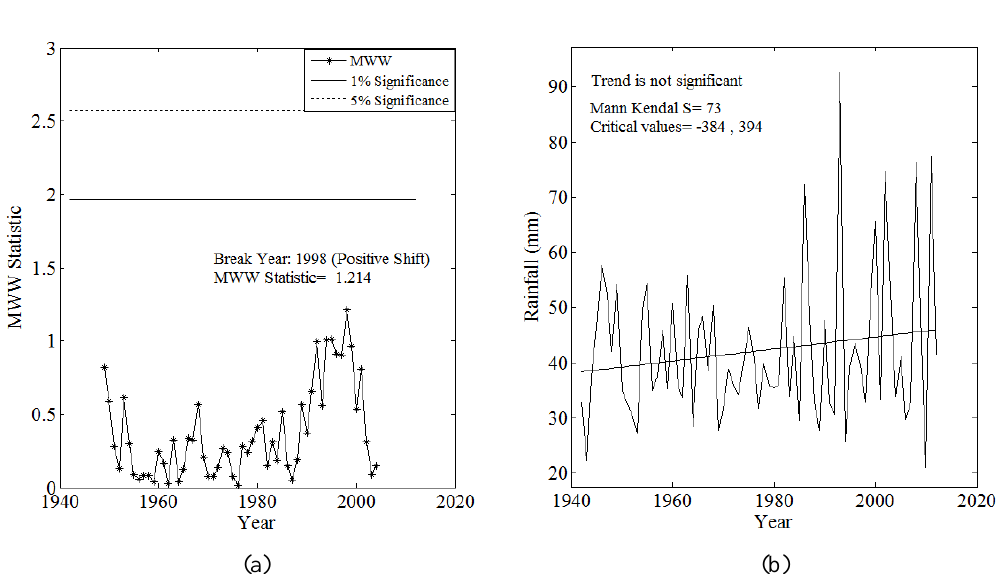
Figure 2. MWW (a) and MK (b) test results for mean annual maximum rainfall for Station no. 532.